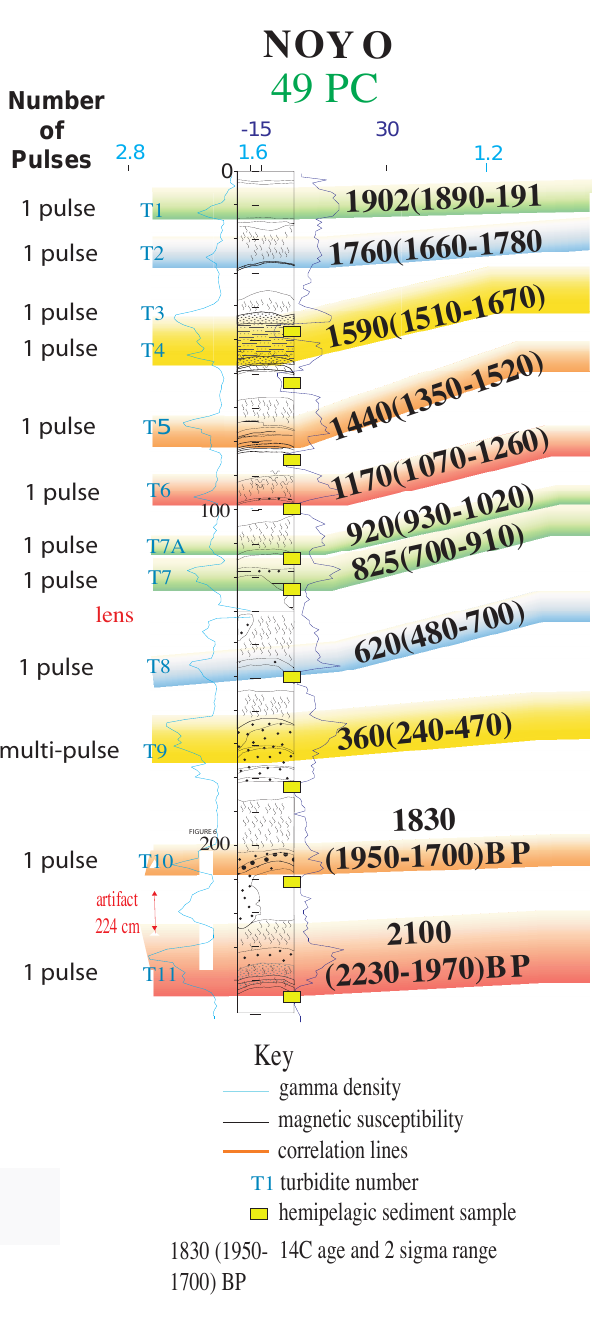
Fig. 6. Number of pulses per turbidite in Noyo Channel of the north- ern California margin based on physical properties and lithology. Note that we have interpreted the density signature as the most re- liable proxy of grain size and these show that 11 of the first 12 tur- bidites in Noyo Channel are uni-pulsed. Ages for the first 9 tur- bidites are years AD and for turbidites 10 and 11 are calibrated radiocarbon years BP (Figure is modified from Goldfinger et al.,